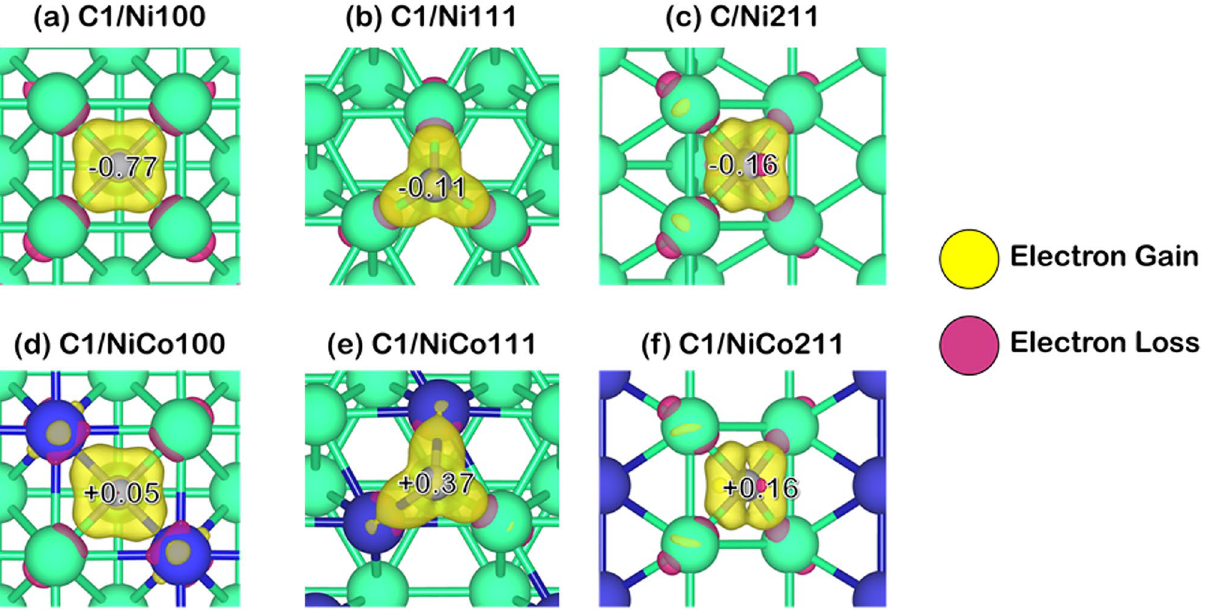
Figure 6. The charge density difference corresponding with Bader charge changes of C1 coke species adsorption on Ni and NiCo surfaces with an isovalue of ± 0.015 |e|/Å 3